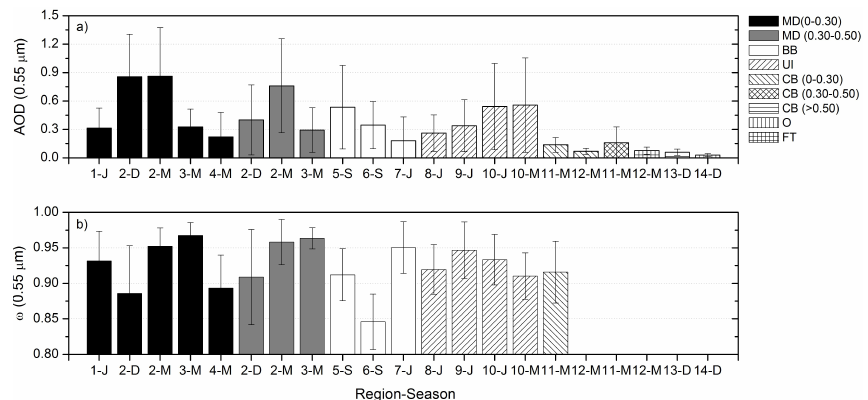
Fig. 5. Multi-year average of aerosol optical depth, AOD, at 0.55µm (a) , and single scattering albedo, ω , at 0.55µm (b) , for each region and season. M=March-April-May, J=June-July-August, S=September-October-November and D=December-January-February. The legend shows each aerosol type: MD=Mineral Dust, BB=Biomass Burning, UI=Urban-Industrial, CB=Continental Background, O=Oceanic and FT=Free Troposphere. For the regions influenced by desert mineral dust and continental background, the AOD and ω averages have been evaluated for each interval of surface albedo (SA): 0–0.30, 0.30–0.50 and > 0.50. Error bars indicate ± 1 σ ( σ , standard deviation).